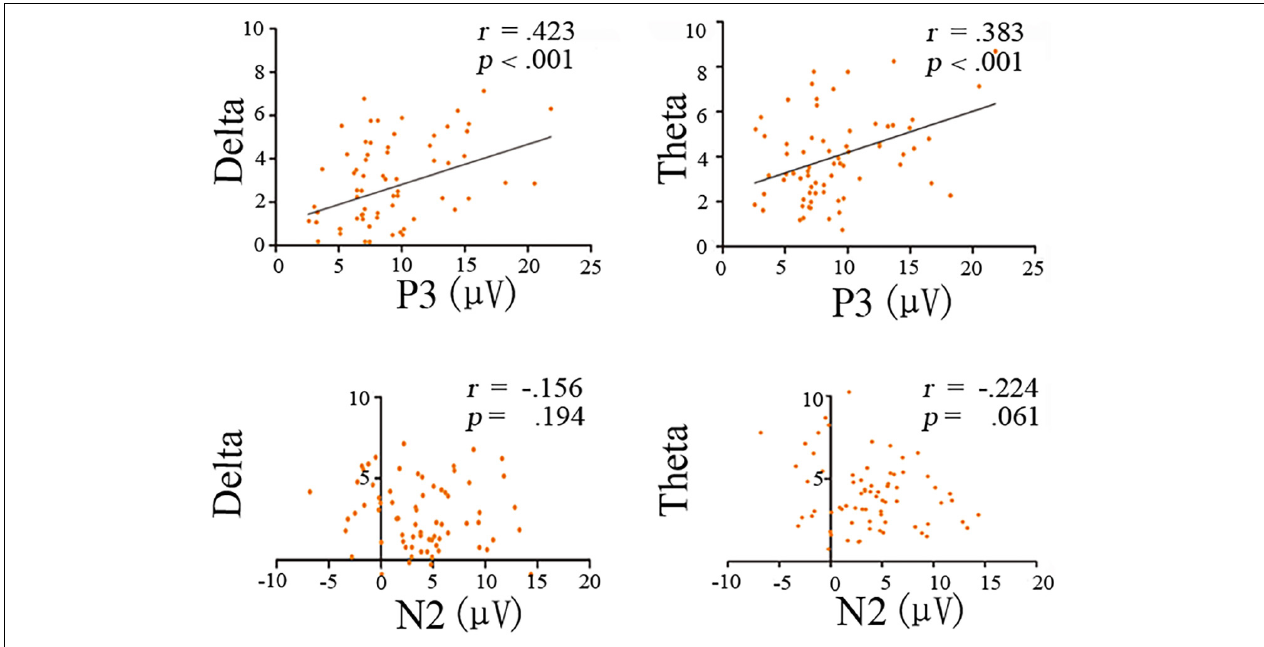
FIGURE 5 | Scatterplot for correlations between time-frequency bands (theta and delta powers) and ERP mean amplitudes (N2 and P3) for the deviant condition.